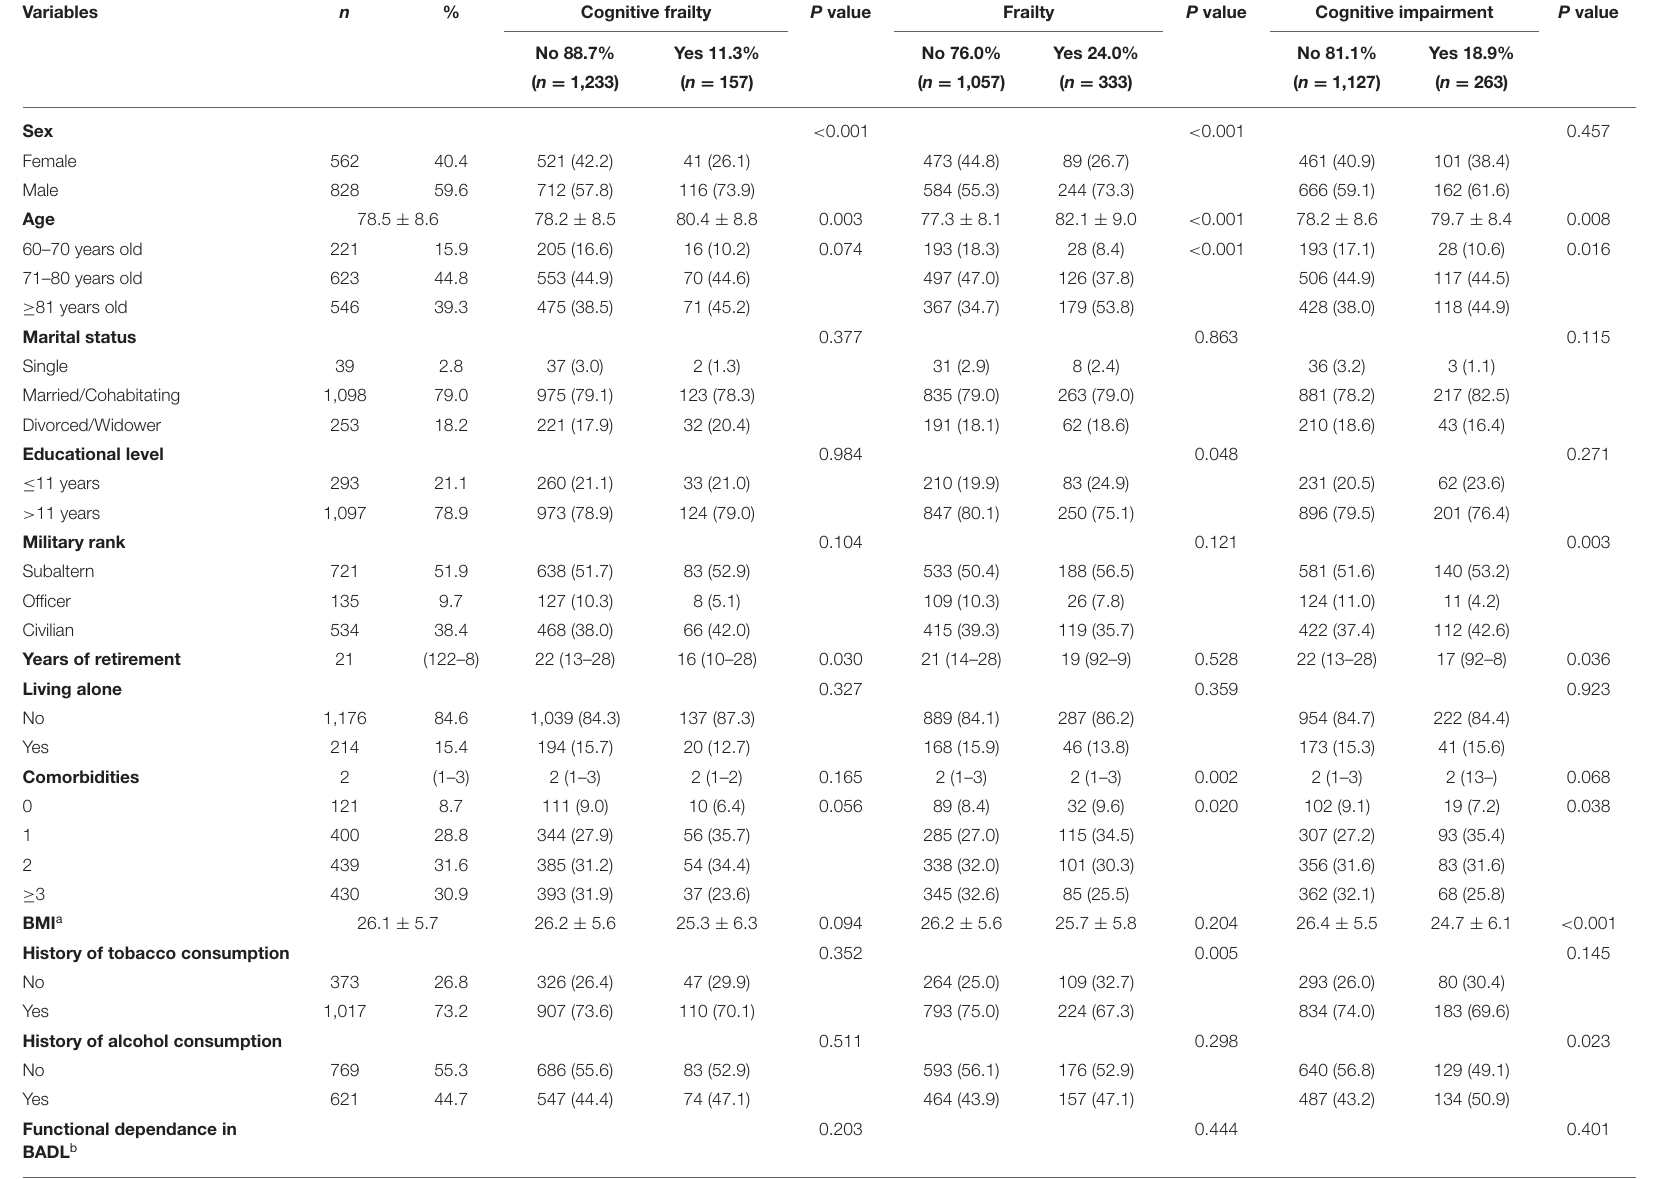
TABLE 1 | Descriptive and bivariate analyses according to exposure variables ( n =